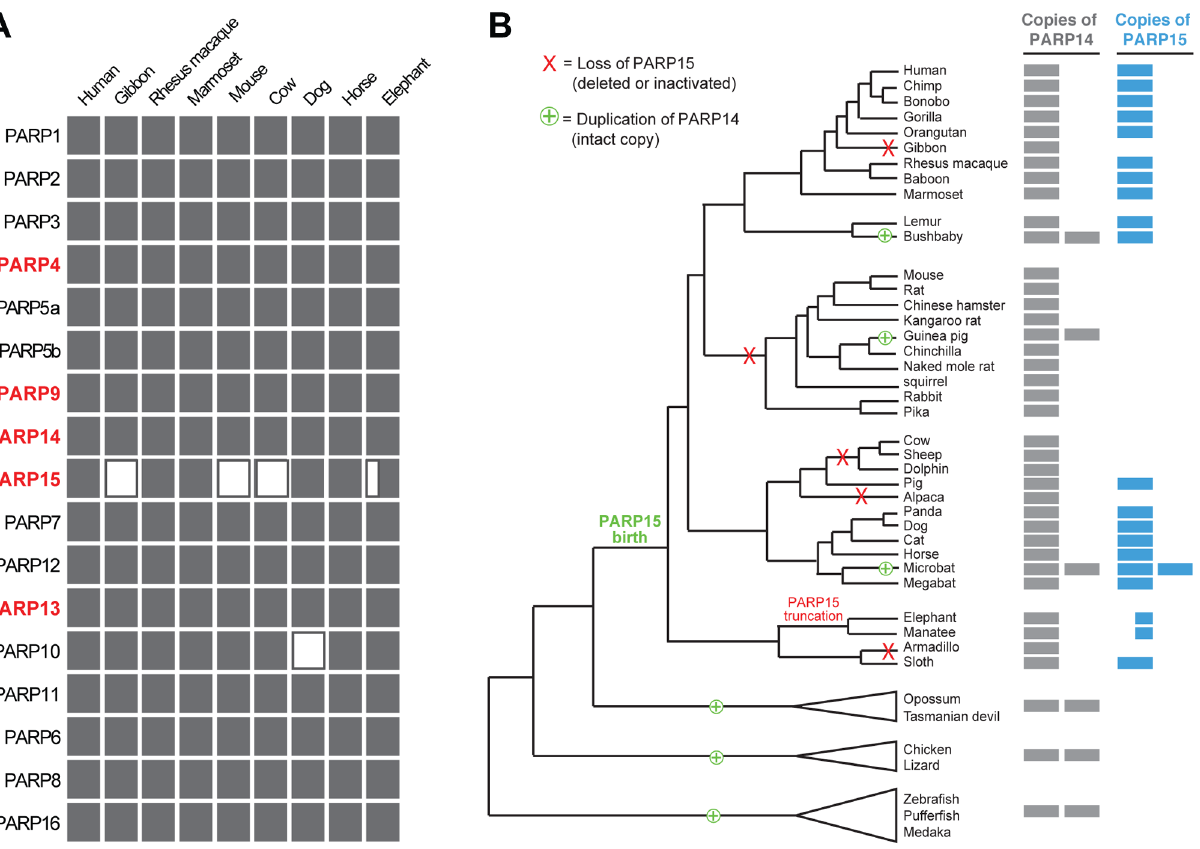
Figure 4. Recurrent gain and loss of PARP14 and PARP15 . (A) Intact PARP genes were identified in representative (high quality assembly) mammalian genomes. Filled rectangles indicate the presence of an intact gene, open rectangles indicate a gene loss. The half-filled rectangle indicates a large N-terminal truncation of PARP15 in the elephant genome. (B) Intact PARP14 and 15 homologs were compiled from publicly available vertebrate genomes (see Figure S6). A phylogenetic tree of queried species is shown with PARP14 duplications (including the birth of PARP15 ) and losses of PARP15 indicated. To the right is an indication of the number of intact PARP14 and PARP15 homologs in each genome, as indicated by the filled rectangles.